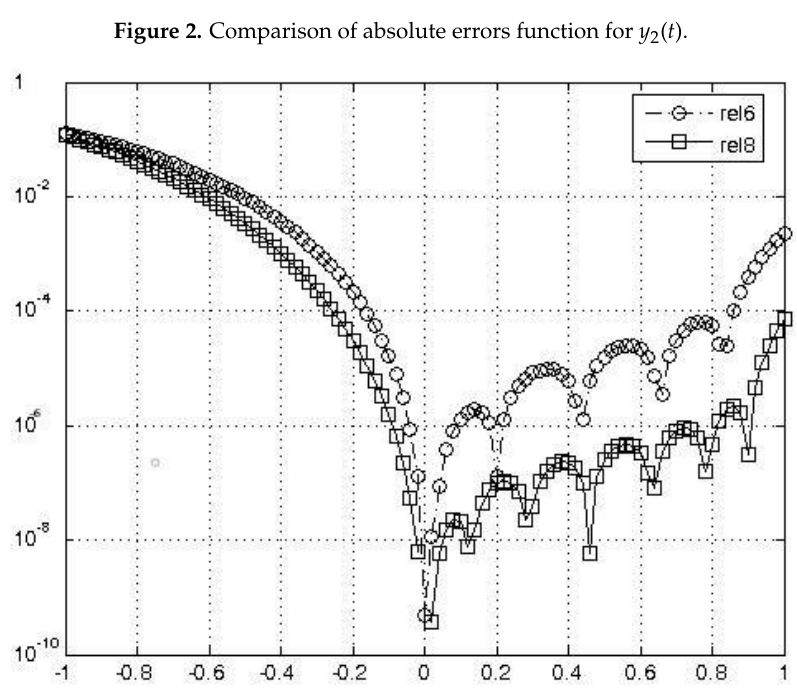
Figure 3. Relative errors of y 1 ( t )(